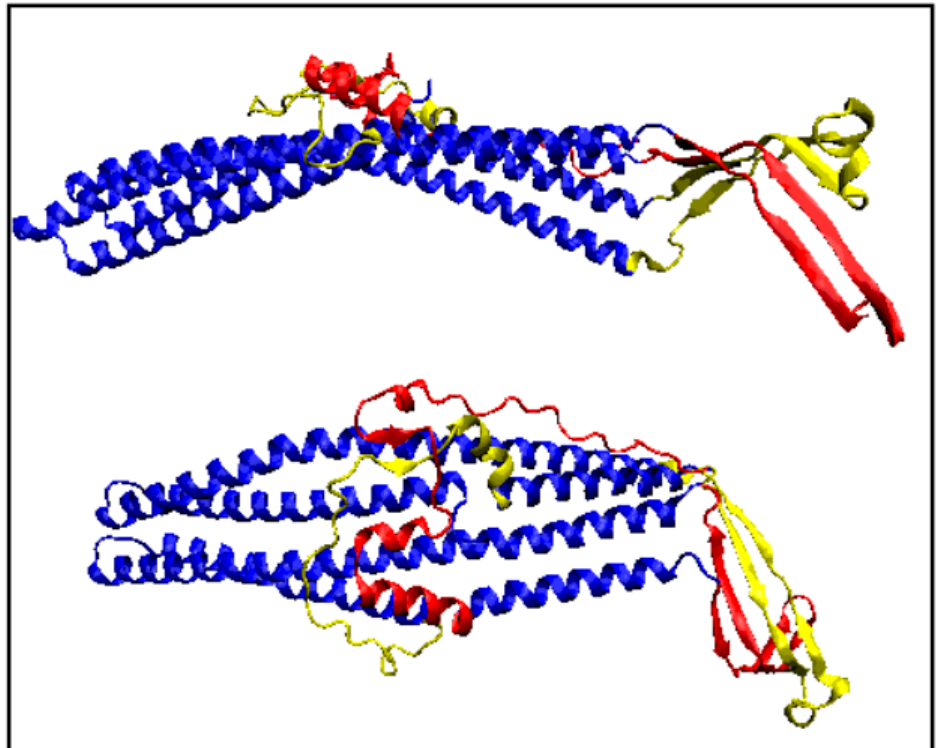
Figure 12. Two different orientations of the dimer structure: a 6-mer section with distinguished extra-membrane parts (red and yellow depending on whether or not they belong to the monomer) and fragments anchored in the membrane (navy blue).